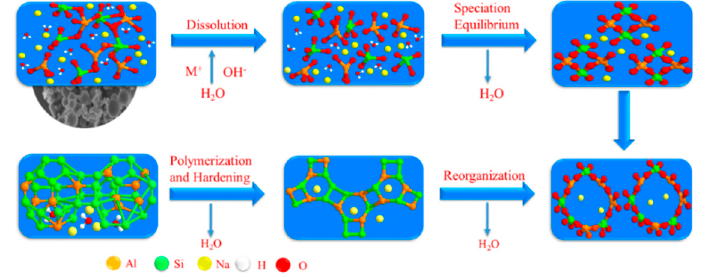
Figure 11. Structural model of geopolymerization.